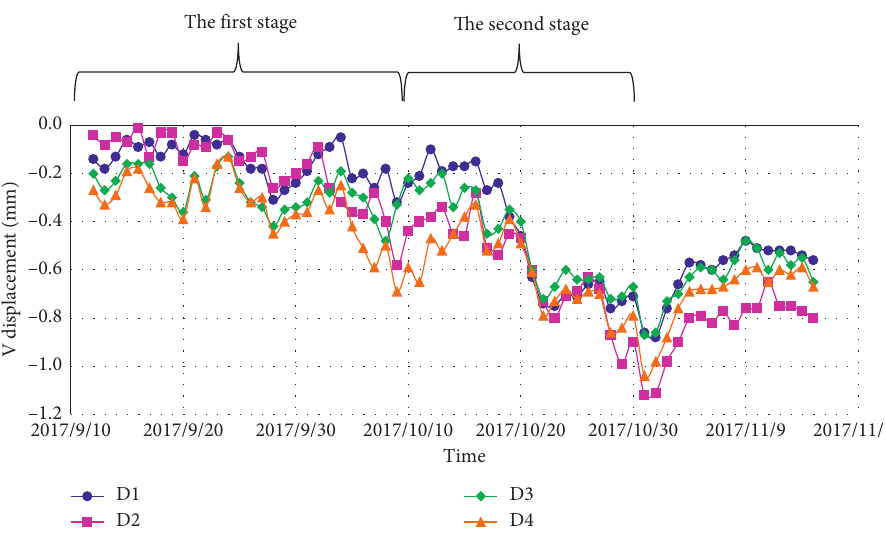
Figure 8: Plot of beam end displacement versus time during construction process.